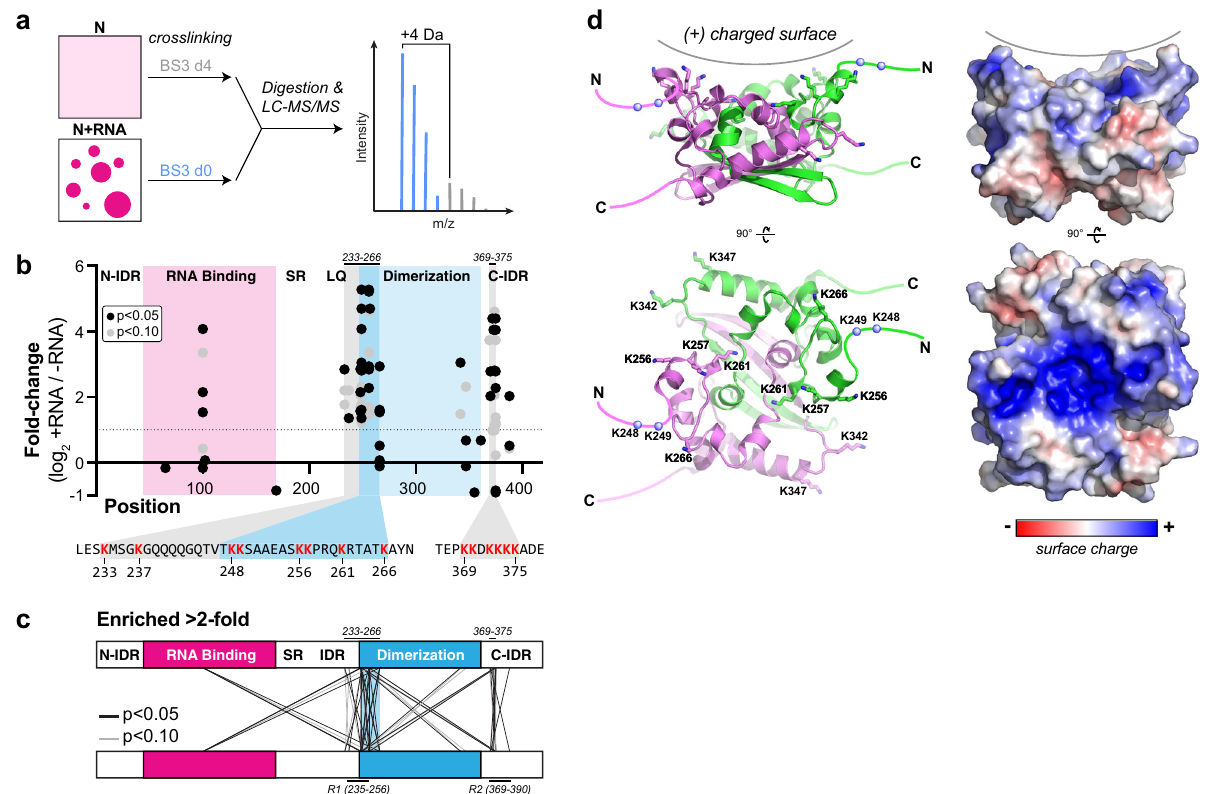
Fig. 4 Cross-linking mass spectrometry of N + RNA condensates. a Soluble N protein or N + RNA condensates (UTR265 or PS576 RNAs; see Supplementary Fig. 4) were cross-linked with isotopically labeled BS3, digested, and analyzed by LC-MS/MS, and each cross-linked peptide was quantitatively compared between the two conditions. b Graph showing the log 2 fold change for each cross-linked peptide in the presence vs. absence of RNA. Average log 2 fold change in three experiments is shown for each cross-linked peptide that showed a p value better than 0.05 (black) or 0.1 (gray) in at least one of the three experimental condition (40 ng/ µ L UTR265, 40 ng/ µ L PS576, or 160 ng/ µ L UTR265 RNA). P values were calculated using a one- tailed t test as described in “ Methods ” section (see Supplementary Fig. 4 and Supplementary Data 1). Since each peptide cross-links two positions, each peptide is graphed twice. The regions spanning residues 233 – 266 and 369 – 375 (sequence shown below) show particularly strong enrichment of cross- linking. c Schematic showing cross-links enriched at least twofold (averaged over three experiments) that showed a con fi dence value better than 0.05 (black) or 0.1 (gray) in at least one experiment. Marked at top are the two regions we identi fi ed as showing strongly increased cross-linking upon RNA- mediated condensation, and marked at bottom are two regions (R1 and R2) identi fi ed by a separate study that show increased cross-linking upon N protein condensation without RNA 57 . d The structure of the SARS-CoV-2 N CTD (PDB ID 6WZQ 21 ) reveals that residues 248 – 266 plus K342 and K347 form a positively charged surface on one face of the CTD dimer (K248 and K249 are disordered in the structure and are represented as blue spheres). Left: cartoon view with monomers colored green and pink; right: electrostatic surface (calculated in PyMOL using the APBS plugin 111